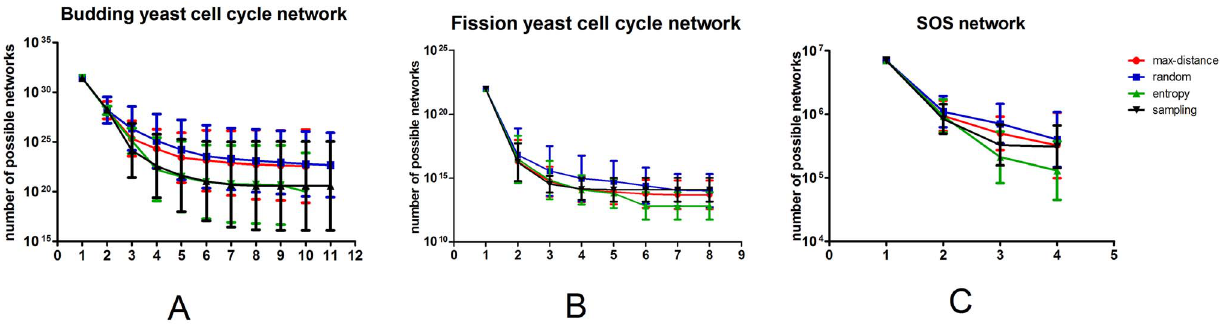
Figure 4. The performances of the three methods when the number of perturbed nodes are limited. For all methods we randomly choose 20 different combinations of perturbed nodes and get the average performance. A, in budding yeast cell cycle network; B, in fission yeast cell cycle network; C, in E.coli SOS network.